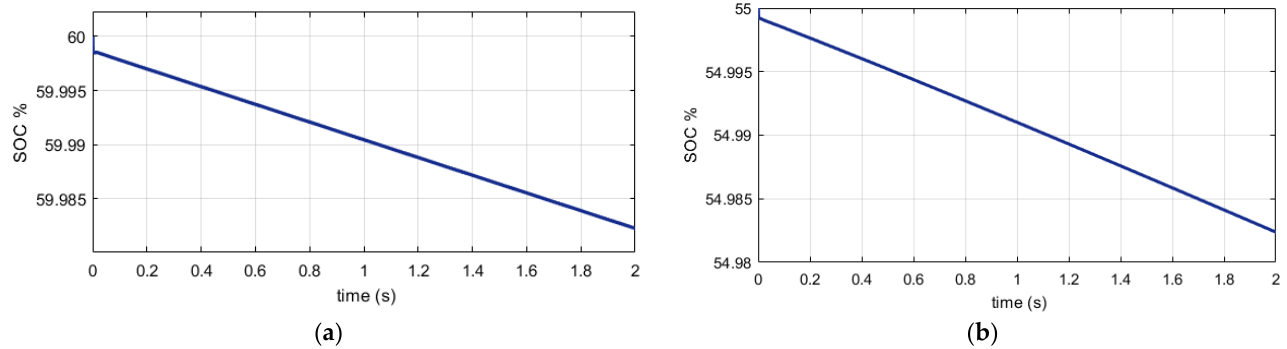
Figure 11. EV and ba tt ery discharging to meet the demand of the loads. ( a ) EV SOC. ( b ) storage